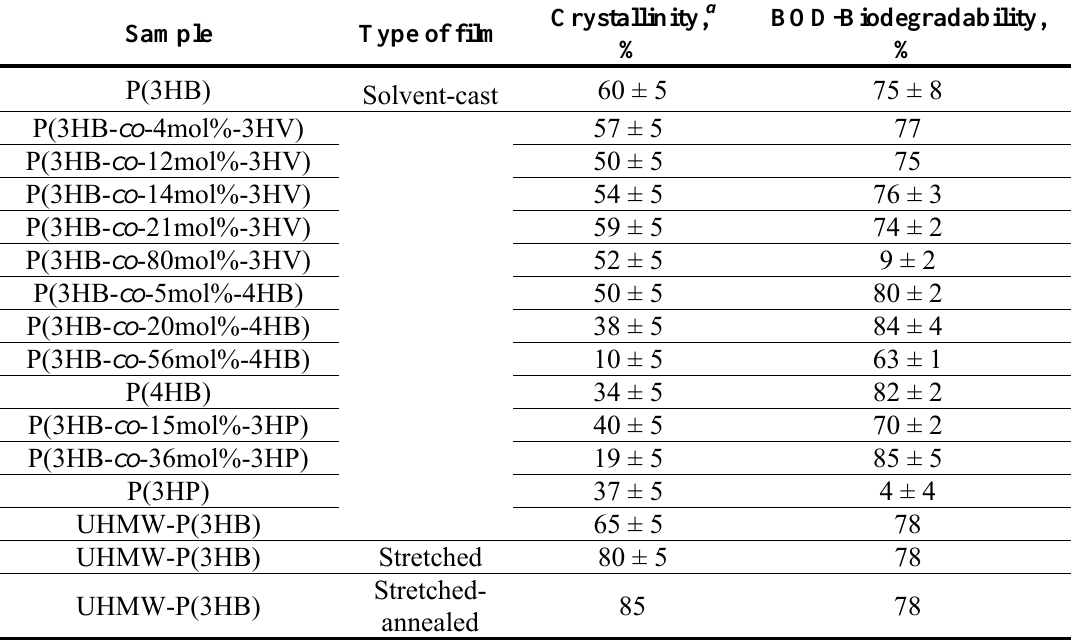
Table 2. BOD-biodegradabilities for 28 days and X-ray crystallinities of PHA films [74,77]. Crystallinity, a Sample Type of film %